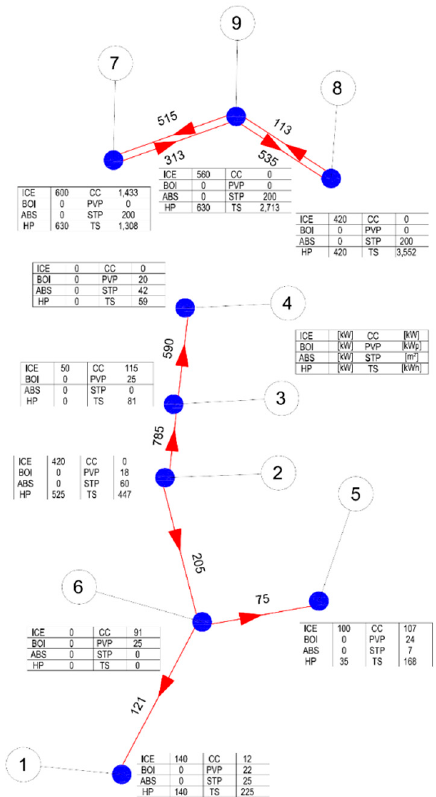
Figure 9. Optimal DHN of the 60% environmental optimum—distributed generation solution. In red the DHN pipes have been reported together with their size (kW). The tables report the size of the components installed.